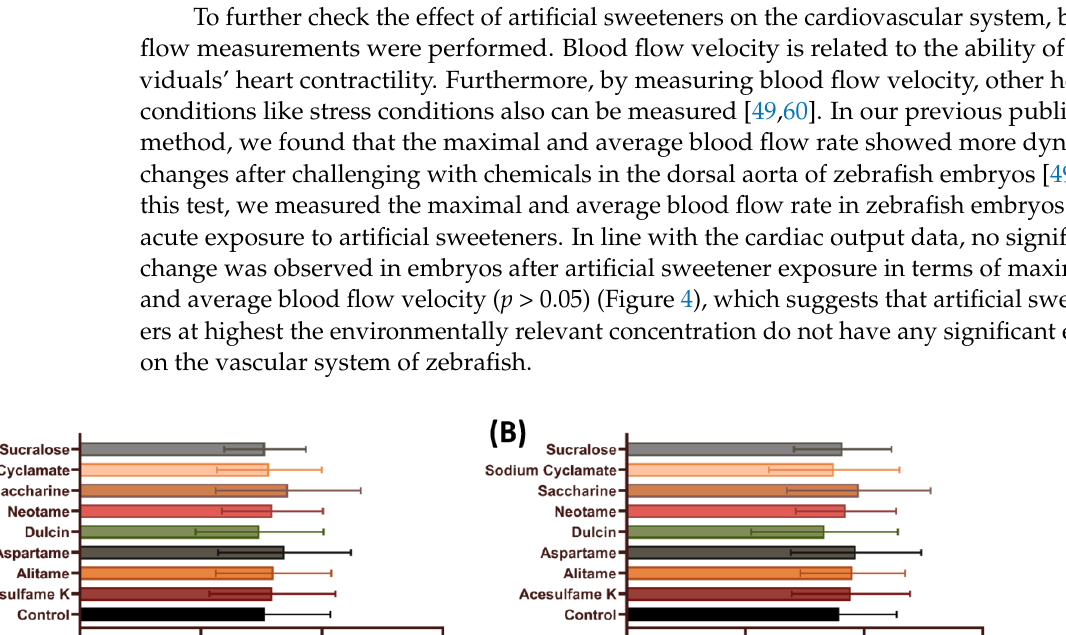
Figure 4. Comparison of maximum ( A ) and average ( B ) blood flow velocity in zebrafish larvae after acute incubation of eight different artificial sweeteners at highest environmental relevant concentration (100 ppb). Data were presented as mean ± SD and statistical significances were tested by Ordinary One-Way ANOVA test followed by Fisher’ LSD test as post-hoc multiple comparison test ( n = 15).